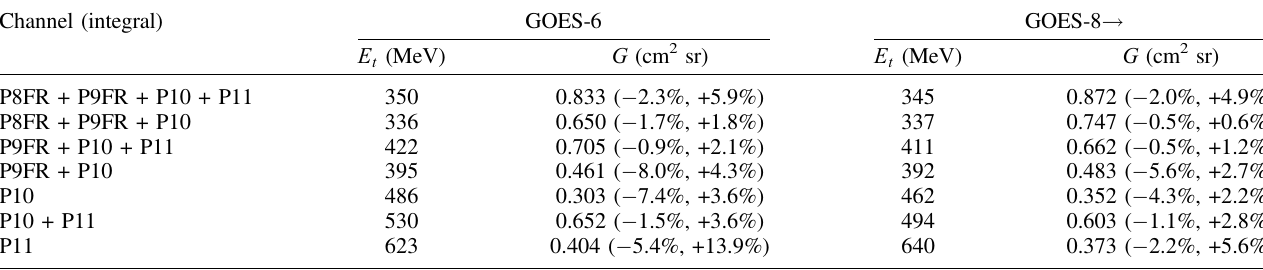
Table A.2. Results of bow-tie analysis for integral channels. Channel (integral) GOES-6